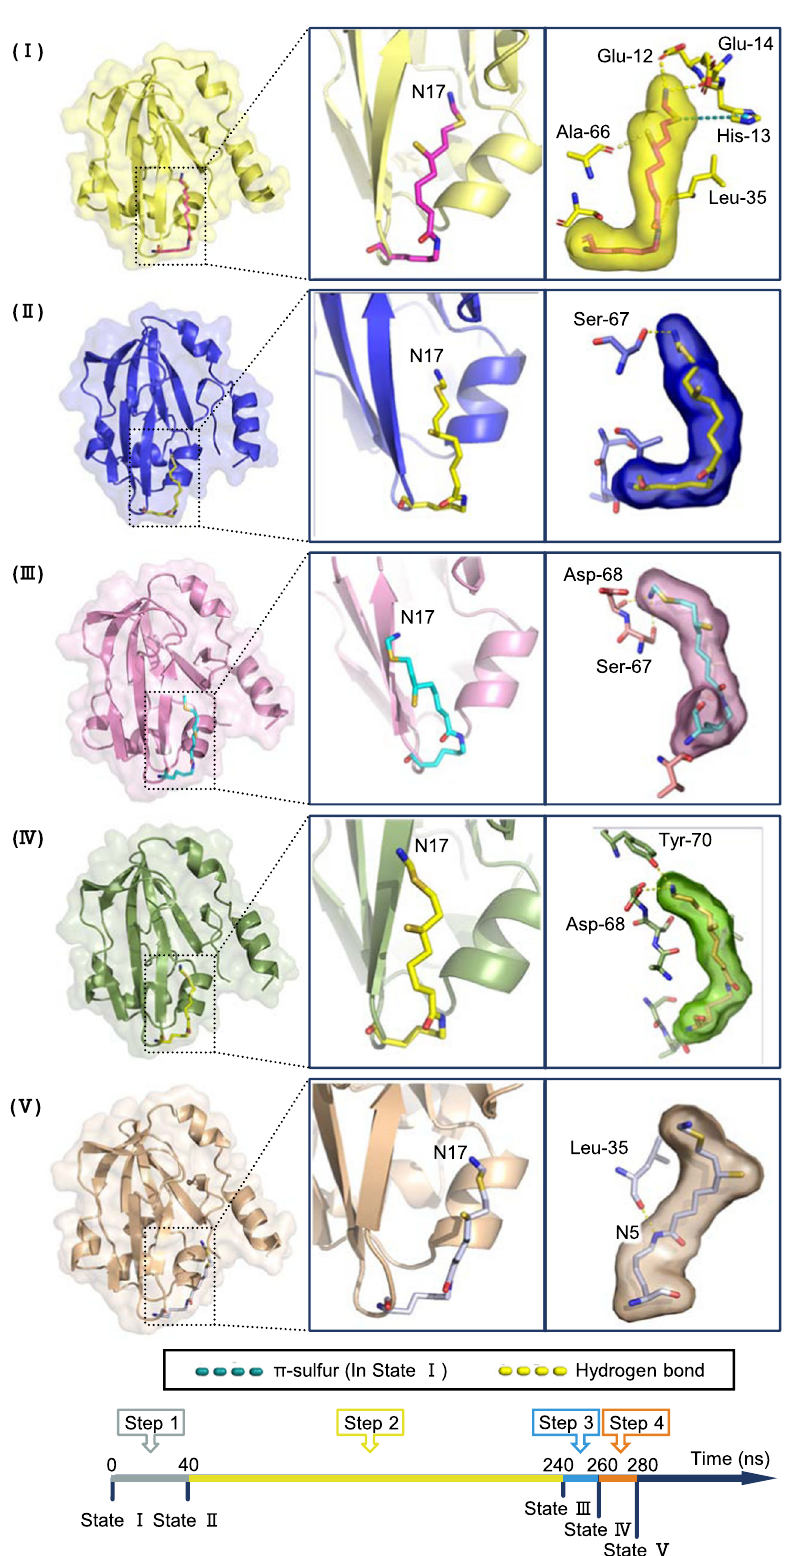
Fig. 3 Five distinguished states of the release process of the aminomethyl lipoate arm from the cavity of protein H which divide the whole process into four major steps. State V de fi nes the time point at which the aminomethyl lipoate arm completely leaves the cavity of protein H. Time spent (in nanoseconds) in each step is summarized in the bottom panel. In panel I (State I), hydrogen bonds and π -sulfur interactions at the beginning are